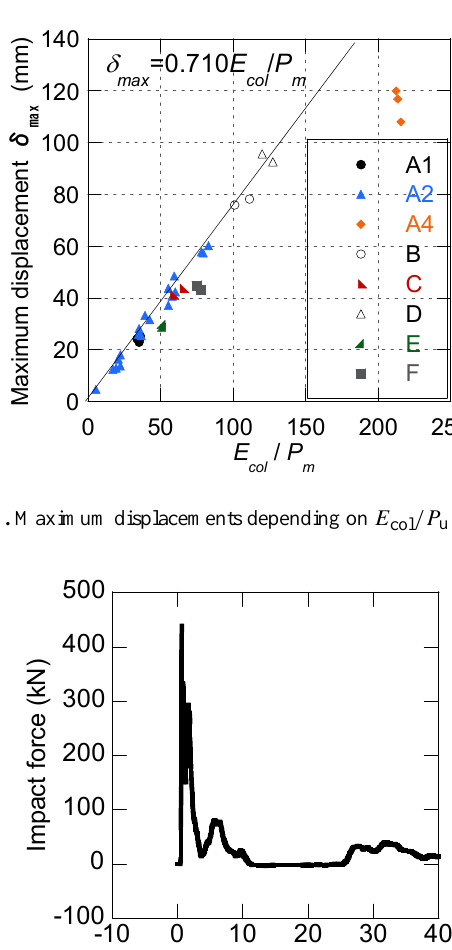
= 5 m/s) Fig. 12. Time response of impact force for test No. 16 (type A4, col